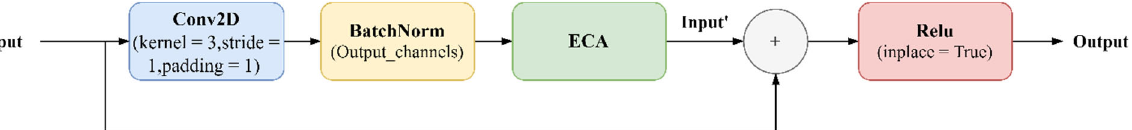
Figure 3. The structure of the ECA-Rest Block is shown in the figure. The input of each block is summed with the original input after a 2D convolution, BatchNorm, and ECA module, and after a ReLU activation layer, we can take the output of this block.